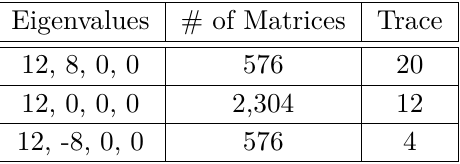
Table 26 . Eigenvalue equivalent classes of 3,456 distance matrices in class (2.2).